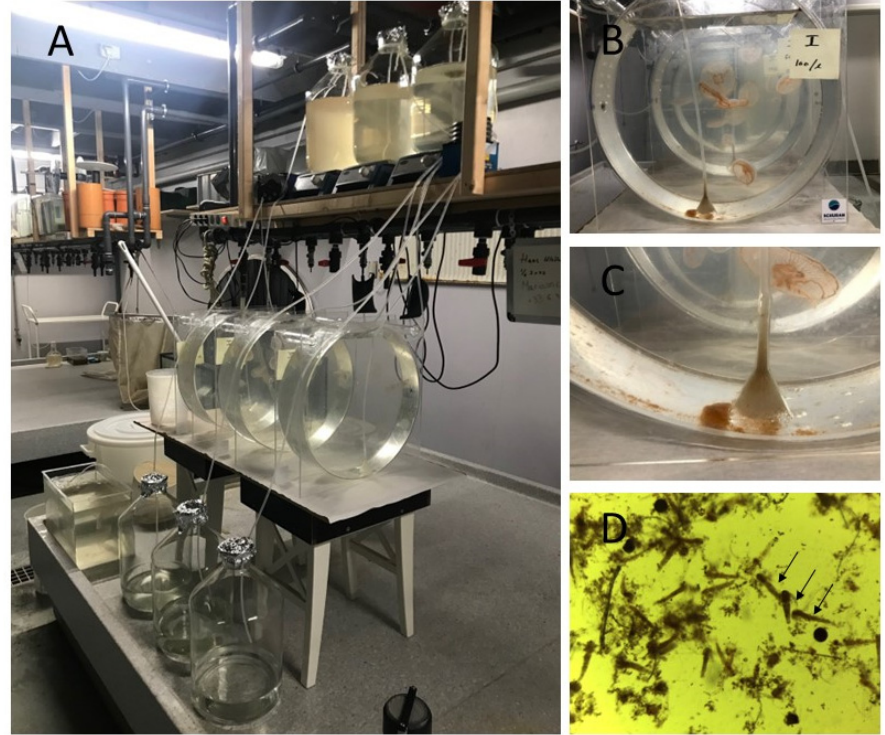
Figure 4. ( A ) Experimental set-up with 3 Kreisler tanks on a bench and above that a shelf with peristaltic pumps dosing 3-day Artemia from well-mixed 10 l stock glass flasks placed on magnetic stirrers. The outflow water is collected in glass flasks below the tanks. ( B ) Tank with 6 small Aurelia aurita . ( C ) Accumulated pseudofeces on the bottom near a small glass funnel packed with cotton and connected to the opening of the outflow tube to prevent jellyfish from being sucked up. ( D ) Jellyfish pseudofeces consists of both living and dead 3-day Artemia (arrows) as well as black sphere-shaped unhatched cysts entangled in mucus.